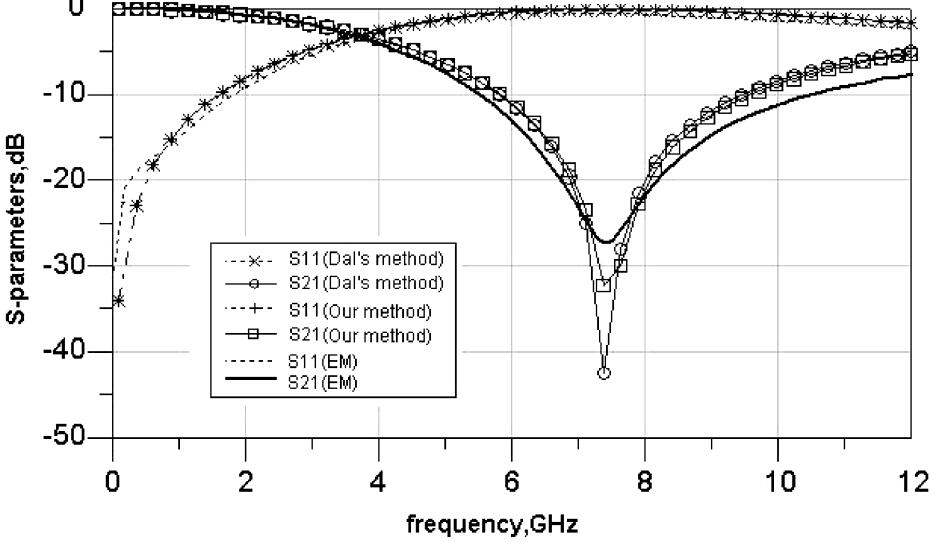
FIGURE 2 Characteristics of a microstrip line